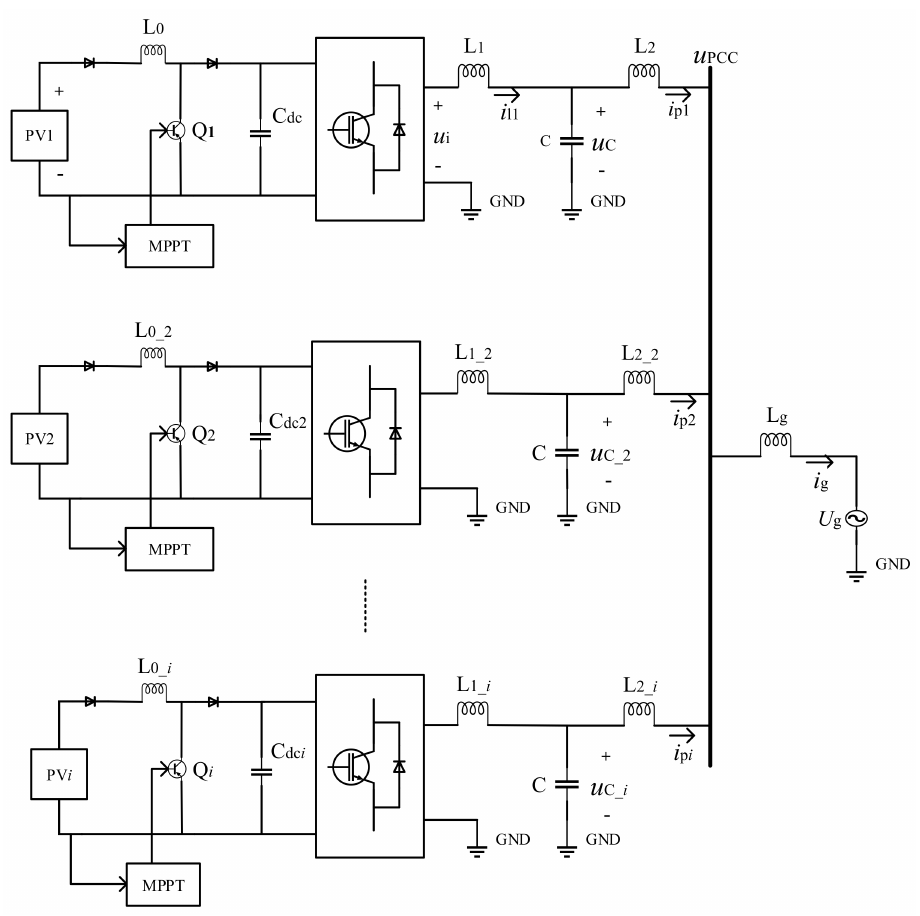
Figure 1. Photovoltaic inverter cluster system schematic